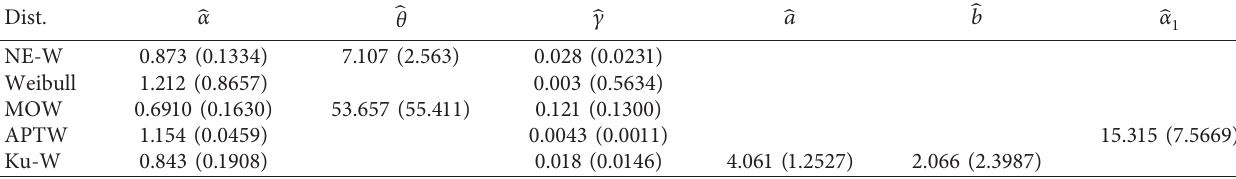
Table 3: Maximum likelihood estimates with standard errors (in parenthesis) of the fitted distributions for data 1. Dist.